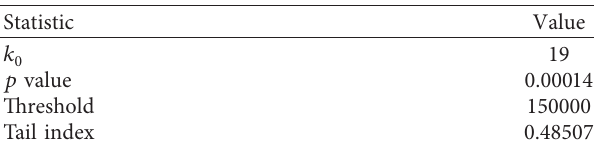
Figure 3: Threshold selection tools. (a) Mean residual life plot. (b) Parameter stability plot. (c) Gertensgarbe plot. Up and Ur are the series of differences from start to end and end to start, respectively, and k is the observation number in the order statistics. Table 2: Mann–Kendall test